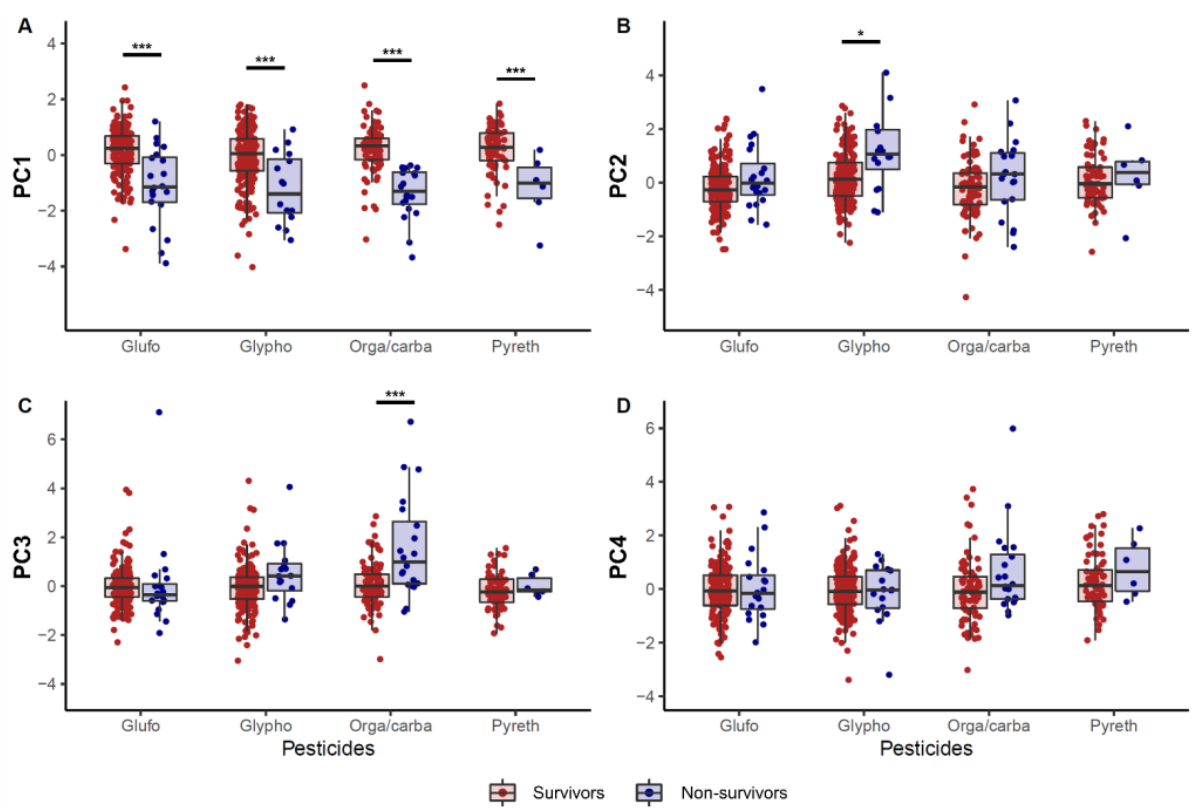
Figure 4. Differences in principal components according to the pesticide category. ( A ) principal component 1, ( B ) principal component 2, ( C ) principal component 3, and ( D ) principal component 4. * p < 0.05, *** p <